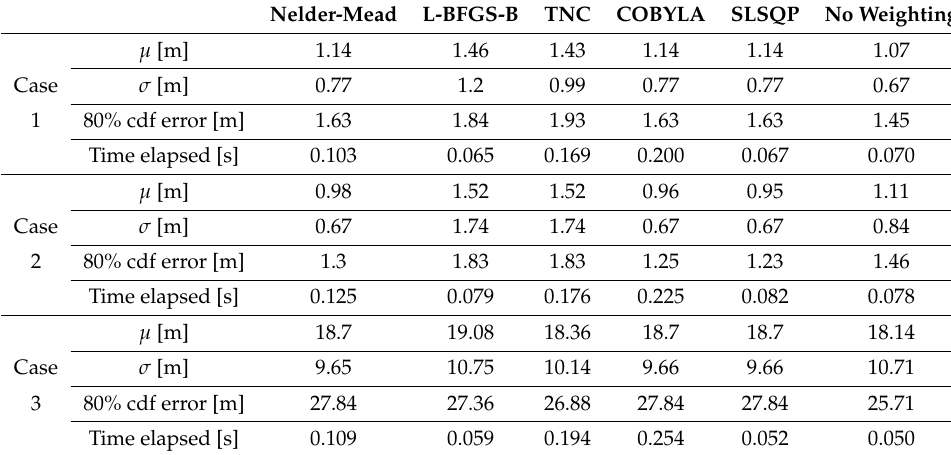
Table 3. Comparison of the search methods in both